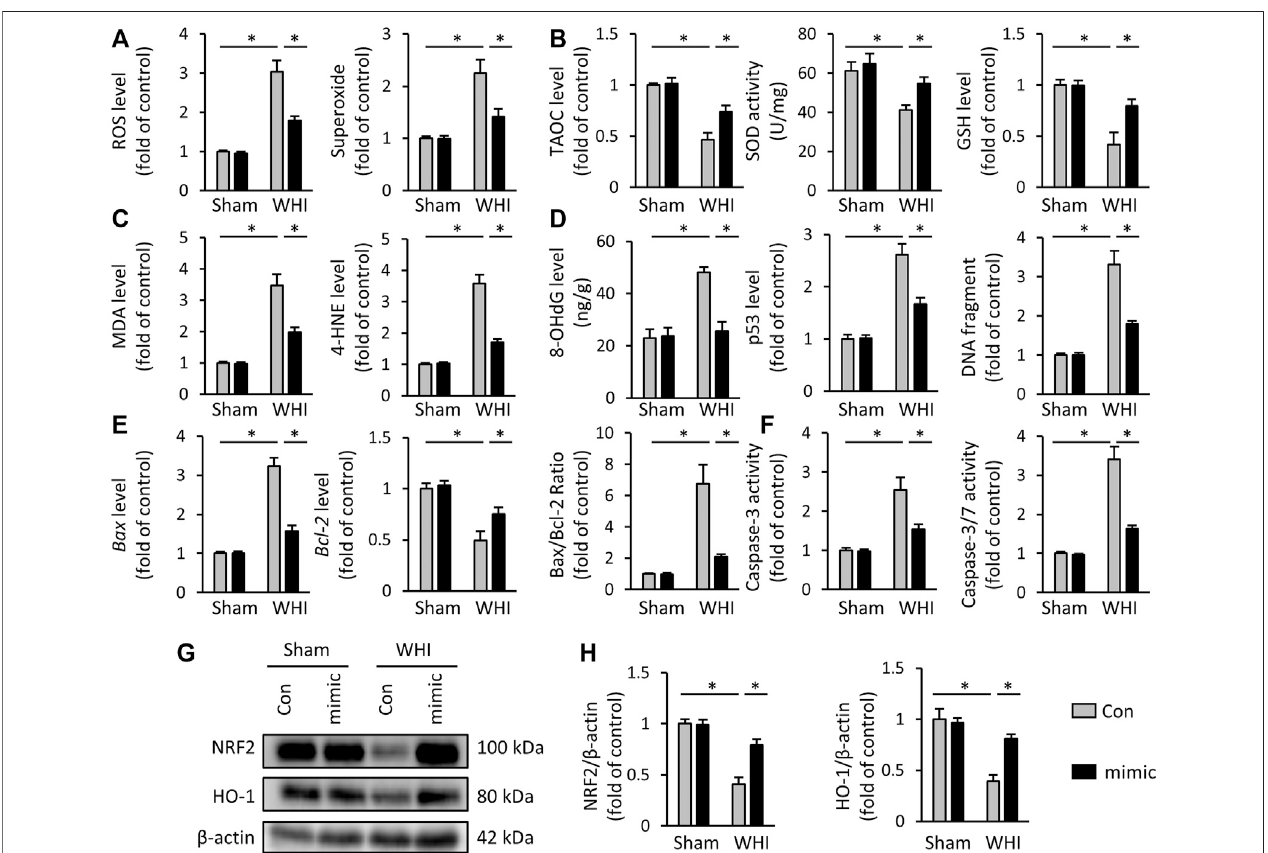
FIGURE 2 | miR-223-3p mimic inhibits oxidative stress and programmed cell death in WHI mice. (A) ROS and superoxide level in the hearts with or without miR- 223-3p mimic ( n (cid:2) 6). (B) TAOC and total SOD activity and GSH level detected by ELISA assay ( n (cid:2) 6). (C) Oxidative products levels in mice hearts ( n (cid:2) 6). (D) Quantitative results of8-OHdG, p53, and DNA fragment ineach group ( n (cid:2) 6). (E) Relative mRNA levels of Bax and Bcl-2 and theratioofBax/Bcl-2in the hearts ( n (cid:2) 6). (F) Quantitative results ofcaspase-3and caspase-3/7activity in each group ( n (cid:2) 6). (G , H) Relative protein expression ofNRF2 and HO-1 ineach group ( n (cid:2) 6). All data are presented as means ± SD. * p < 0.05 vs. the matched